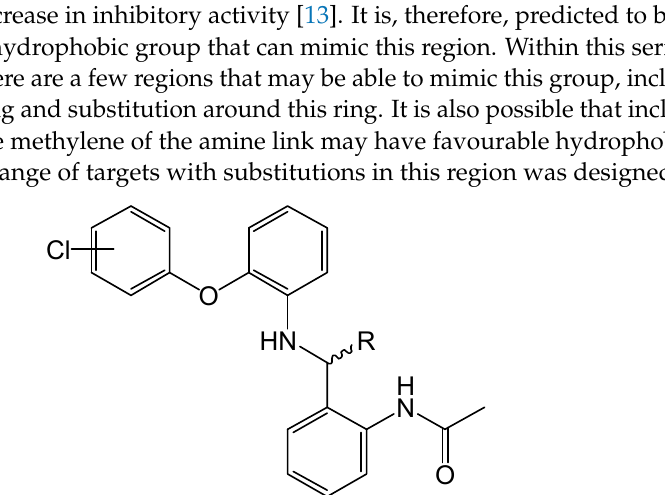
Figure 7. Compounds 24 and 22 docked into the 17 β -HSD3 homology model.